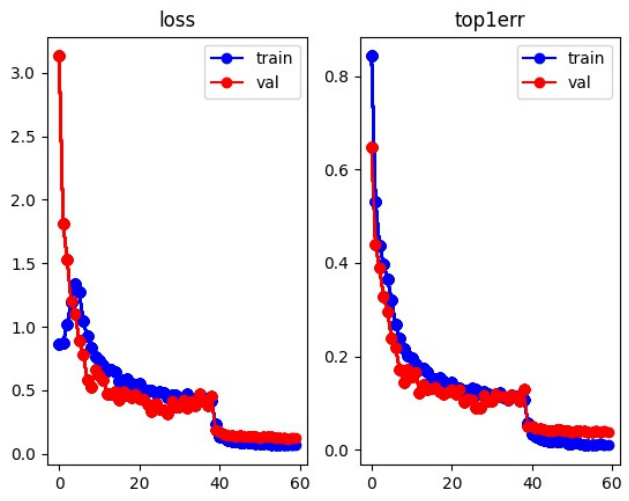
Figure 6. Training and validation loss curve and top1 error curve.